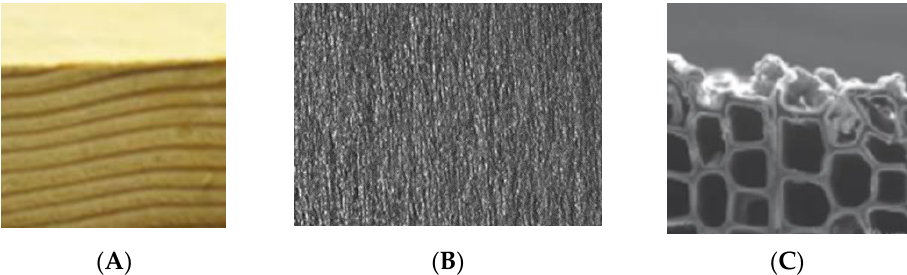
Figure 1. Radiata pine surface ( A ), micrograph wood surface after sanding ( B ), electron-micrograph of wood surface after sanding ( C ).